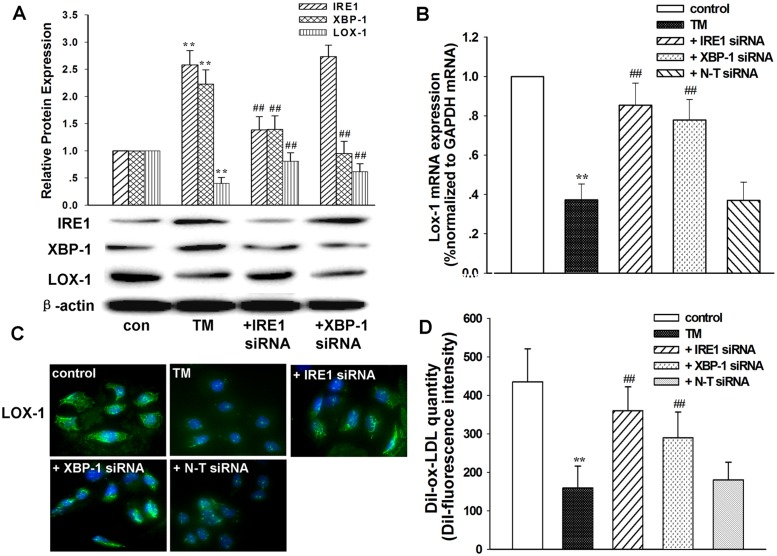
Involvement of the IRE1/XBP-1 signaling pathway in TM-mediated downregulation of LOX-1 and lipid uptake function.A: The effects of IRE1 and XBP-1 siRNA on TM-induced IRE1, XBP-1, and LOX-1 protein expression. Cells were transfected with siRNA targeting IRE1 or XBP-1. Protein expression levels were examined by western blotting. B–D: The effects of IRE1 and XBP-1 siRNA on the TM-induced LOX-1 altered expression. Cells were transfected with siRNA targeting IRE1, XBP-1, or negative control (N-T). The mRNA expression of LOX-1 was examined by real-time PCR (B). The LOX-1 protein expression (C) and lipid uptake (D) in L02 cells were examined by immunocytochemistry and DiI-ox-LDL uptake assays, respectively. Nuclei were counterstained with DAPI (blue). These data are representative of the results of three separate experiments. **P < 0.01 vs. control (0 μg/mL TM), ## P < 0.01 vs. TM (1 μg/mL). TM: tunicamycin.